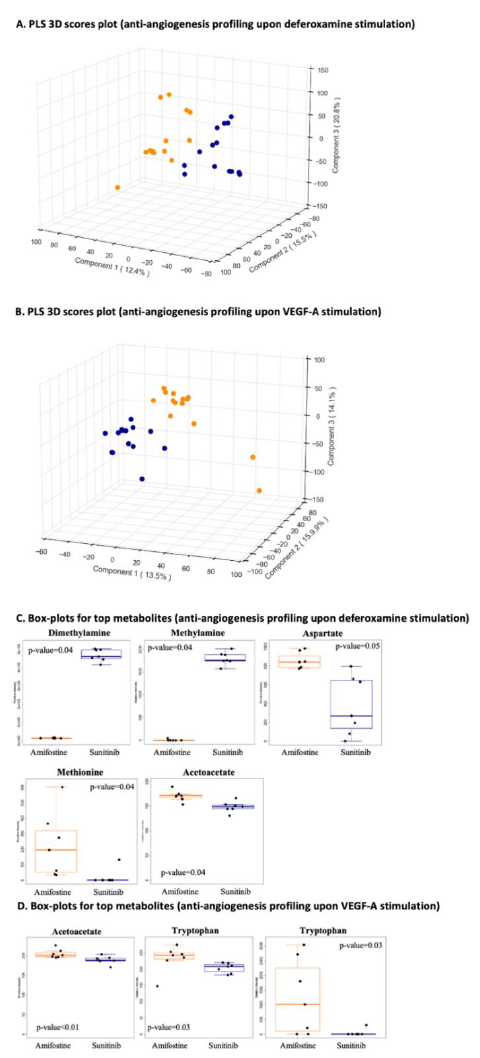
Figure 5. Stimulant-specific anti-angiogenesis profiling. ( A ) Anti-angiogenesis profiling upon deferoxamine stimulation (group comparison-a; amifostine_deferoxamine, n = 14 vs. suni- tinib_deferoxamine, n = 14). PLS 3D scores plot with R2 greater than 0.9 and Q2 equal to 0.8 using five components; ( B ) anti-angiogenesis profiling upon VEGF-A stimulation (group comparison- b; amifostine_VEGF-A, n = 14 vs. sunitinib_VEGF-A, n = 14). PLS 3D scores plot with R2 greater than 0.9 and Q2 equal to 0.8 using five components; ( C ) boxplots of all the statistically significant metabolites and their p -values (FDR corrected) for anti-angiogenesis profiling upon deferoxamine stimulation (group comparison-a); ( D ) boxplots of all the statistically significant metabolites and their p -values (FDR corrected) for anti-angiogenesis profiling upon VEGF-A stimulation (group comparison-b). Group comparisons are color-coded; orange, angiogenesis stimulation and blue, angiogenesis